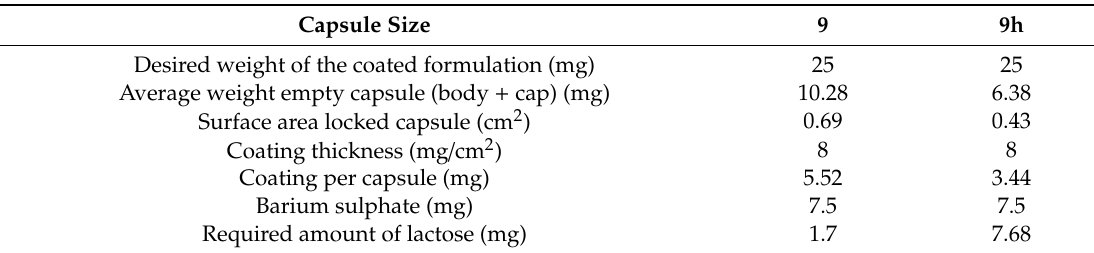
Table 1. Characteristics of the capsules.